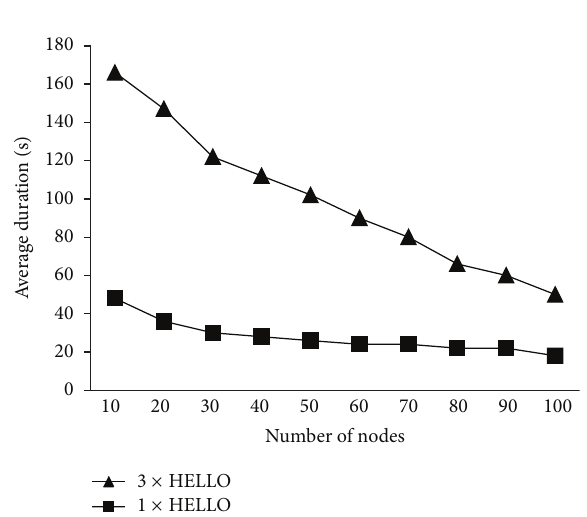
Figure 3: Clusters number versus network density.